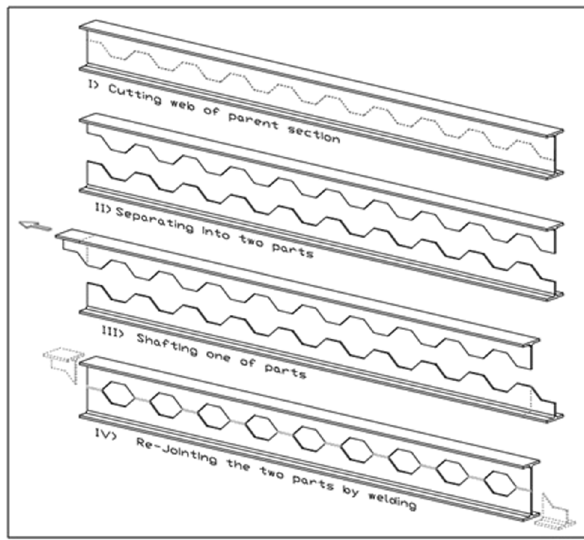
Figure 1: Fabrication of prismatic castellated beams [ 1 ] .